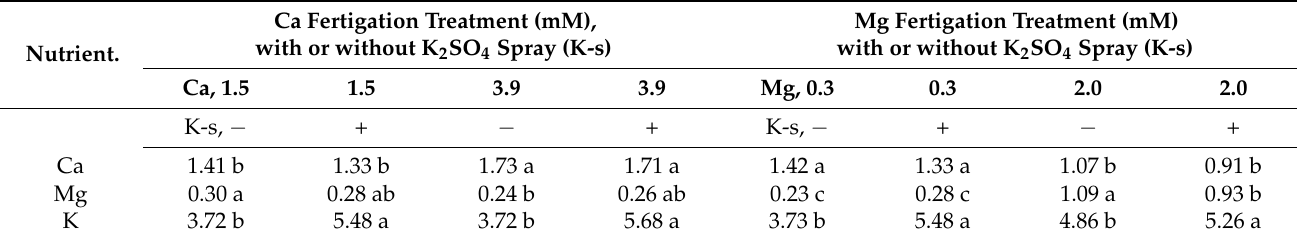
Table 3. Effects of the addition of CaCl 2 or MgCl 2 to the fertigation solution +1% K 2 SO 4 spray on nutrient concentrations (% dry weight) in sweet basil